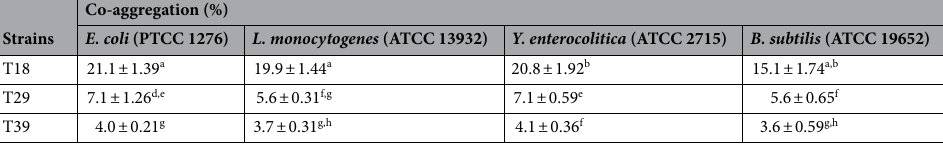
Table 5. Co-aggregation (%) of selected strains with 4 pathogens during 4 h incubation at 37 °C. Values are mean ± standard deviation of triplicates. a–h Means in the same column with different lowercase letters differed significantly ( p ≤